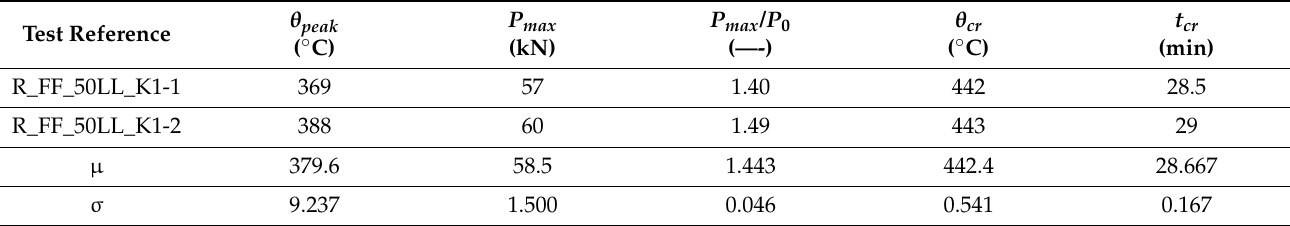
Table 3. Experimental results for fixed R columns.